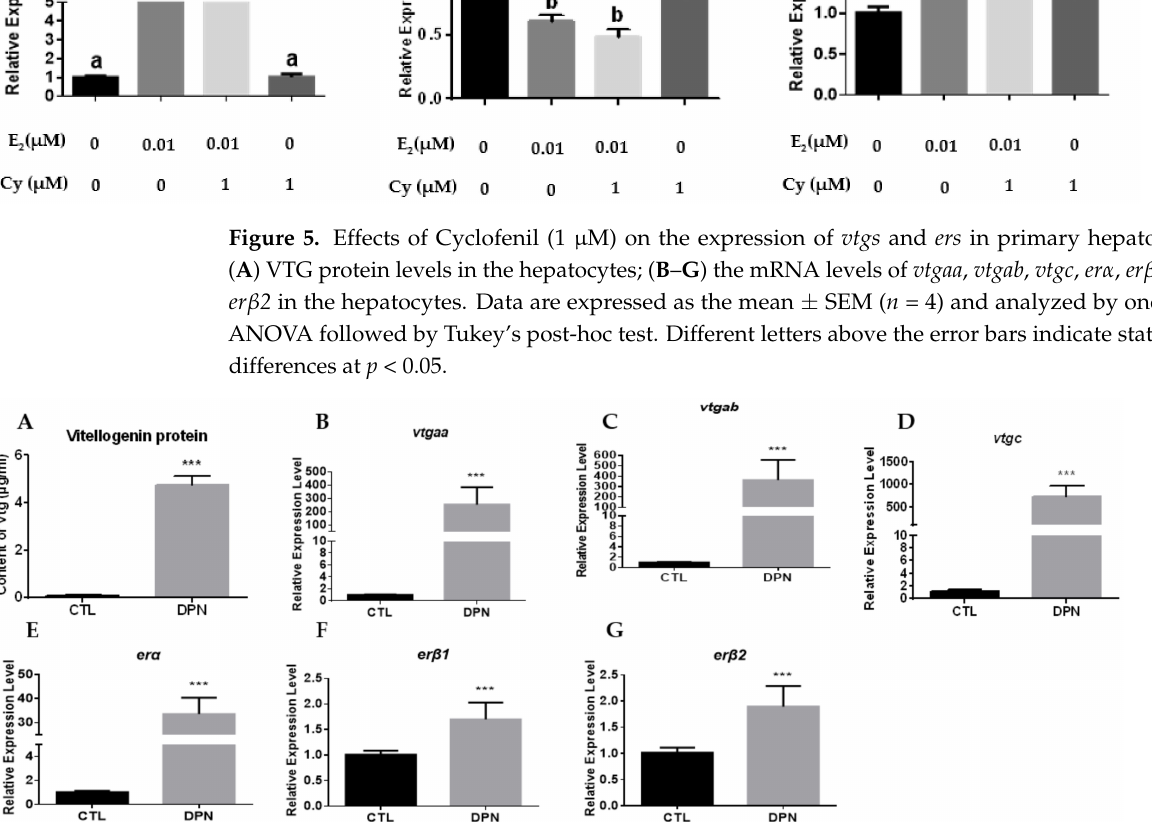
Figure 6. Effects of DPN (1 µ M) on the expression of vtgs and ers in primary hepatocytes: ( A ) VTG protein levels in the hepatocytes; ( B – G ) the mRNA levels of vtgaa , vtgab , vtgc , er α , er β 1 and er β 2 in the hepatocytes. Data are expressed as the mean ± SEM ( n = 4) and analyzed by unpaired Student’s t -test. Asterisks (*) indicate statistical differences (*** p <